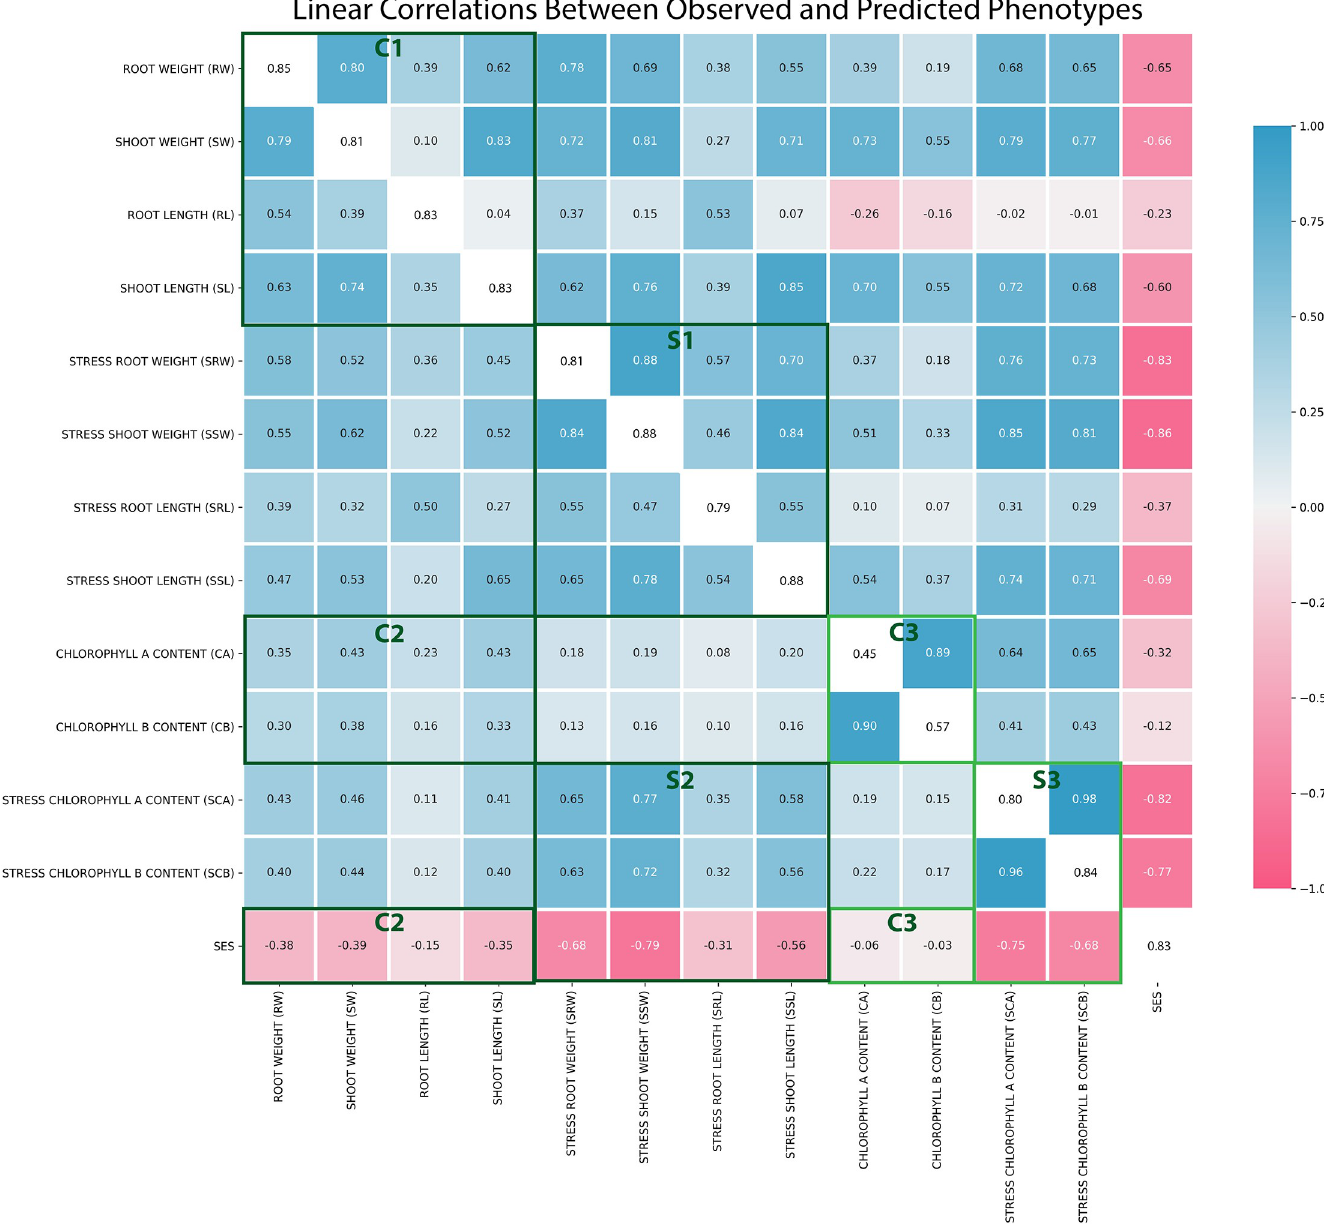
correlation coefficients between the observed phenotypes are shown in the bottom diagonal of the heatmap in Fig 3 and the correlation between the genotype effects for each phenotype cal- culated through genomic prediction occupies the upper diagonal of the heatmap. The correla- tion between the observed phenotypes and additive SNP effects are seen along the white diagonal of the map. All phenotype estimations made by genomic prediction can be found in